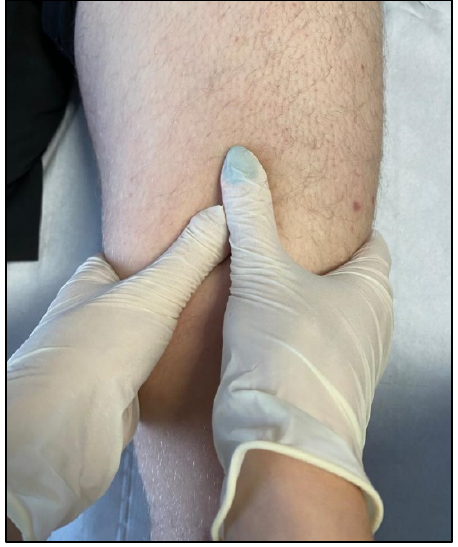
Figure 4. Relaxing massage of the thigh muscles